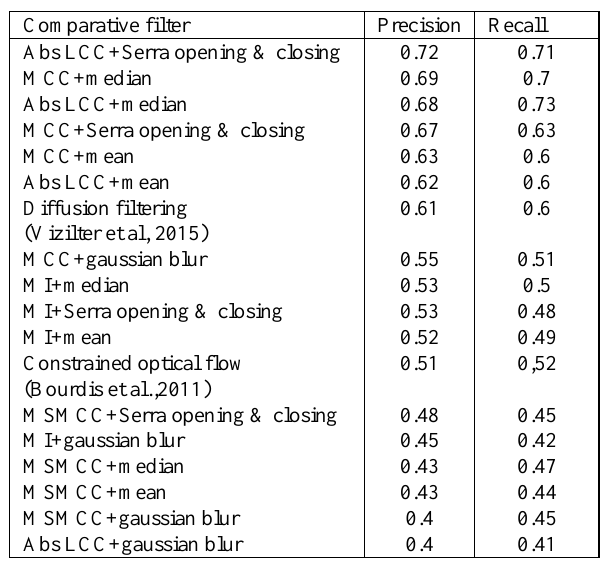
Figure 5. Example of simulated data from benchmark: a) reference image; b) test image; c) ground truth mask.